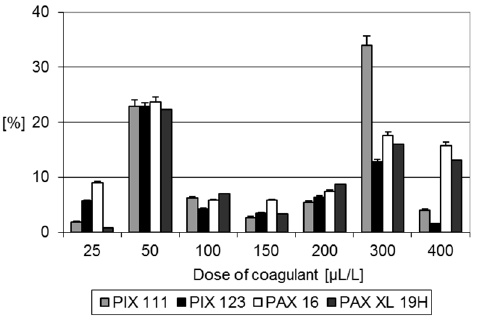
Figure 1. Efficiency of COD removal by coagulation with PIX 111, PIX 123, PAX 16, PAX 19H in the dose ranged from 25–400 μ